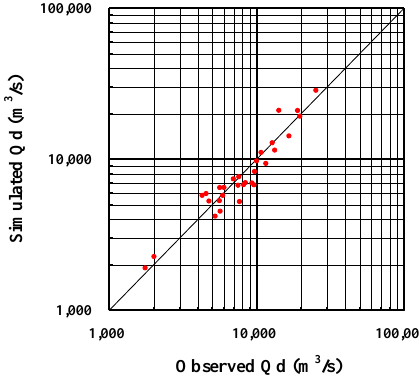
Figure 6. Annual Maximum Series of Observed and Simulated Daily Inflow.